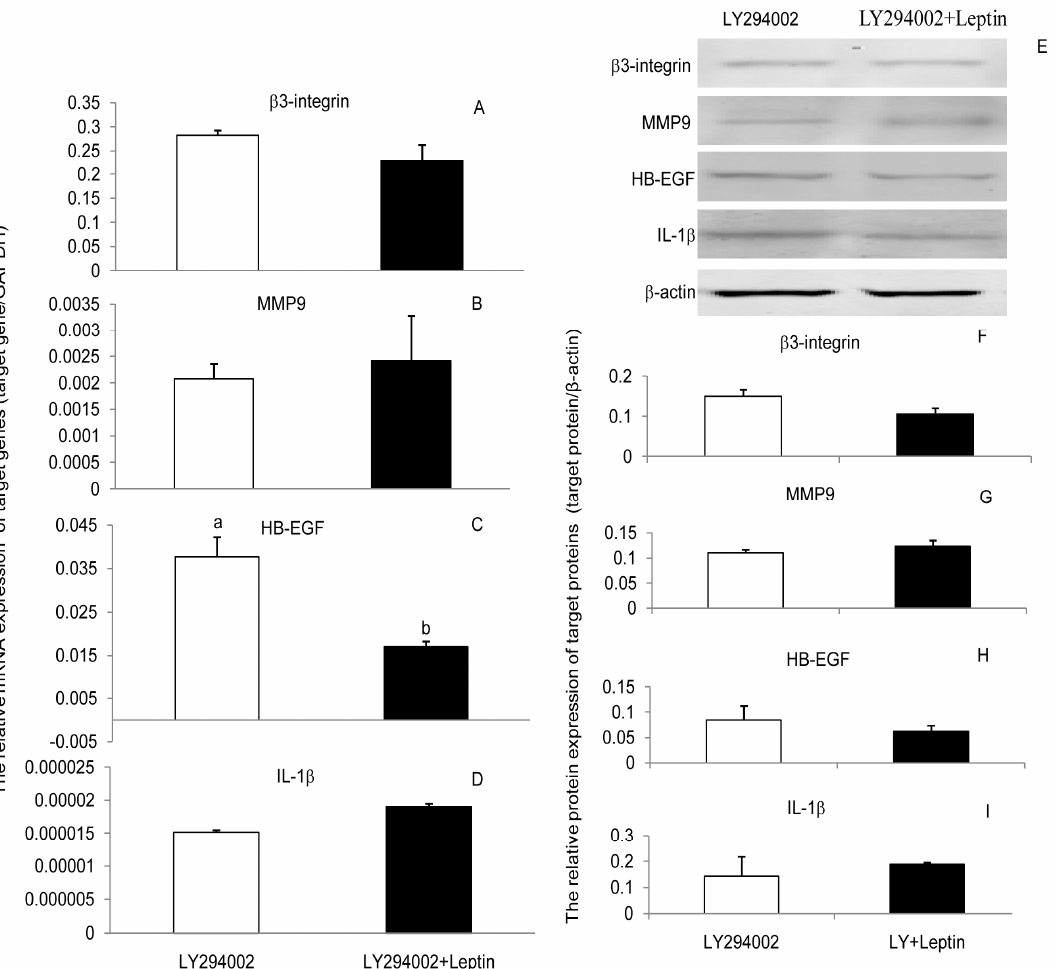
Figure 4. Effect of leptin and LY294002 (inhibitor of PI(3)K) on the expression of β 3-integrin, MMP9, HE-EGF, and IL-1 β mRNA and proteins in primary porcine endometrium epithelial cells (PEECs). A – D : The relative mRNA level of β 3-integrin, MMP9, HE-EGF, and IL-1 β in response to leptin and